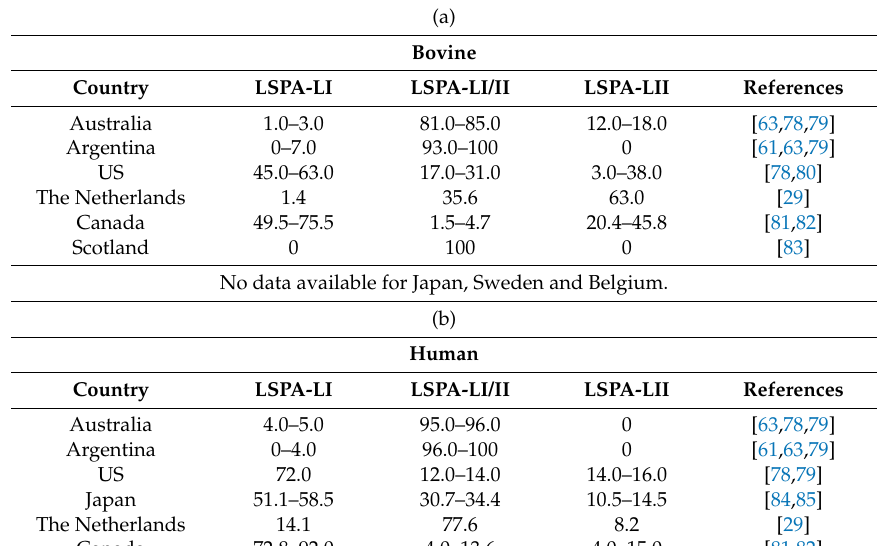
Table 2. Values (or interval of values from different sources) of lineage-specific polymorphism assay-6 (LSPA-6) lineage frequency in (a) bovine, and (b) human E. coli O157 strains from different